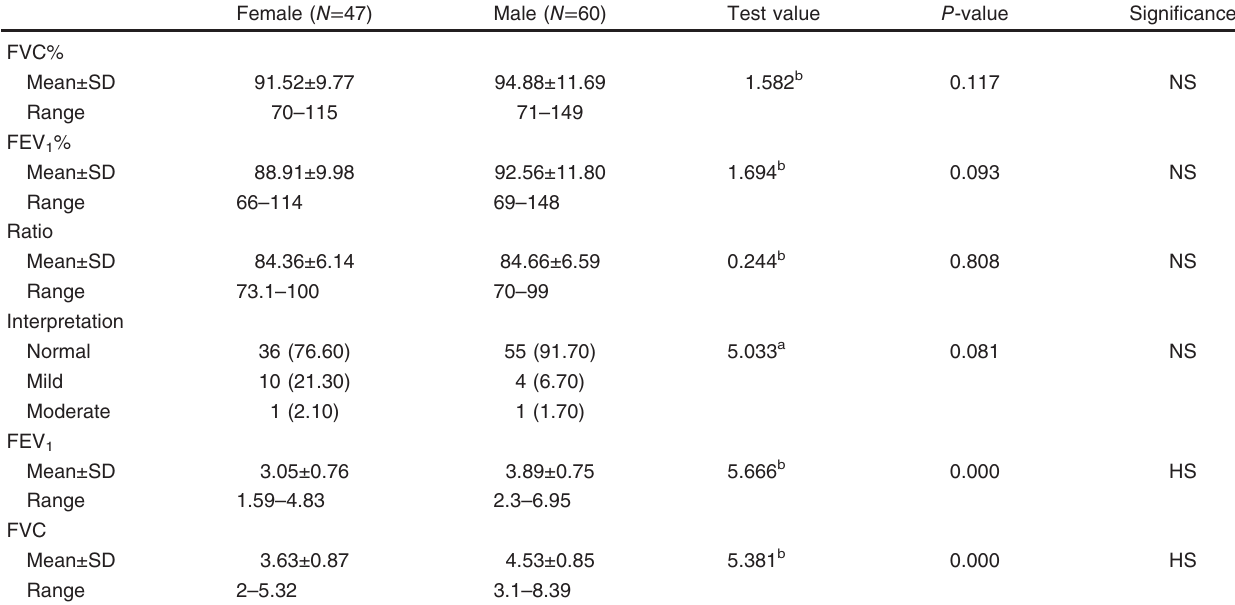
Table 7 Comparison between males and females as regard spirometric